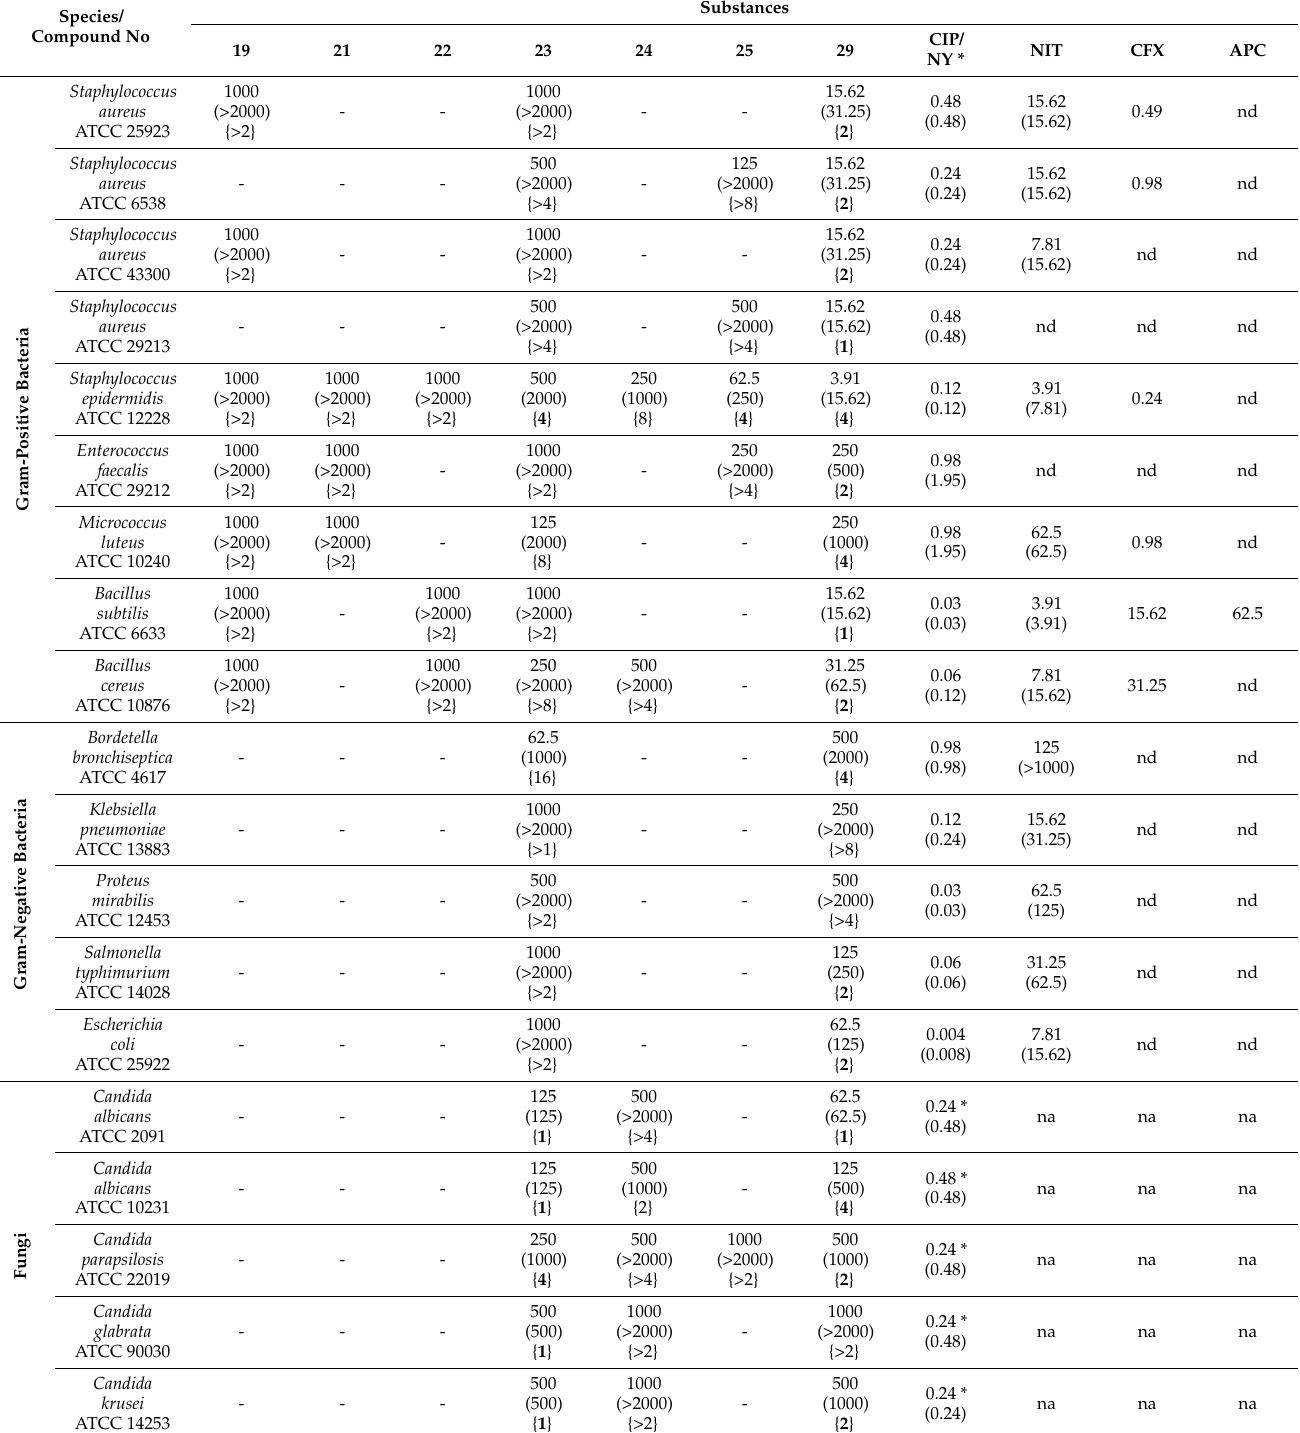
Table 1. The activity data of compounds 16 – 30 expressed as MIC (MBC or MFC) ( µ g/mL) and MBC/MIC or MFC/MIC values against the reference strains of